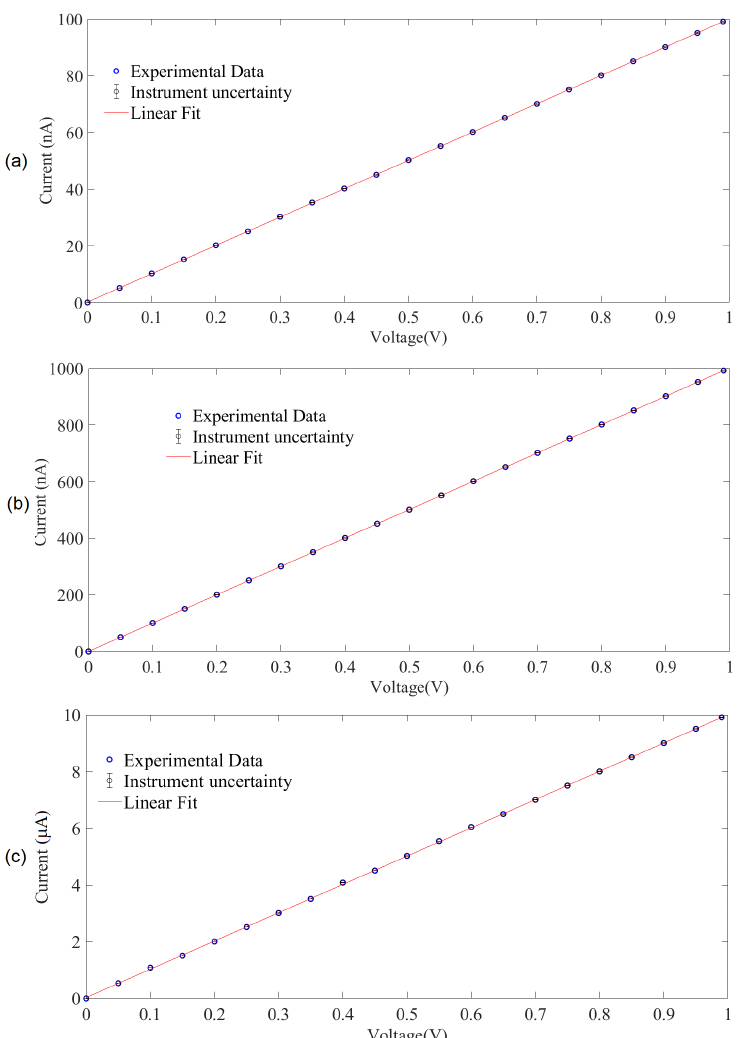
Figure 7. Calibration adjustment. ( a ) Result of the characterization of the ammeter with range from 0 to 100 nA. ( b ) Result of the characterization of the ammeter with range from 0 to 1 µ A. ( c ) Result of the characterization of the ammeter with range from 0 to 10 µ